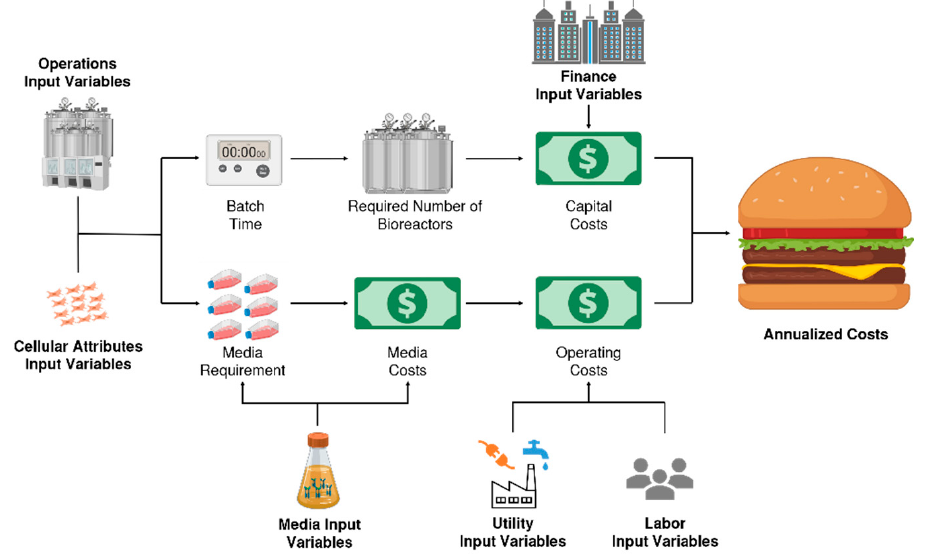
Figure 3. ACBM simplified economic model flow diagram.